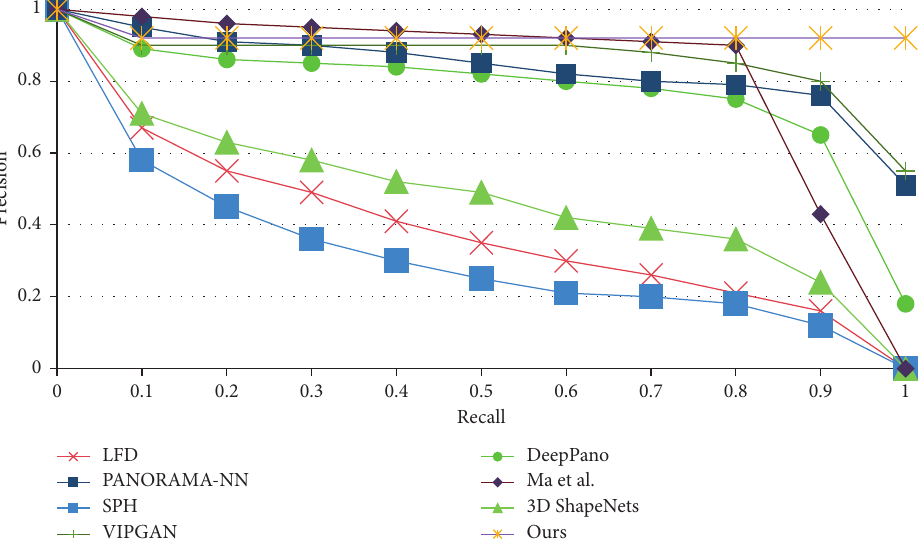
Figure 11: The comparison of precision-recall curves for various methods on ModelNet40.